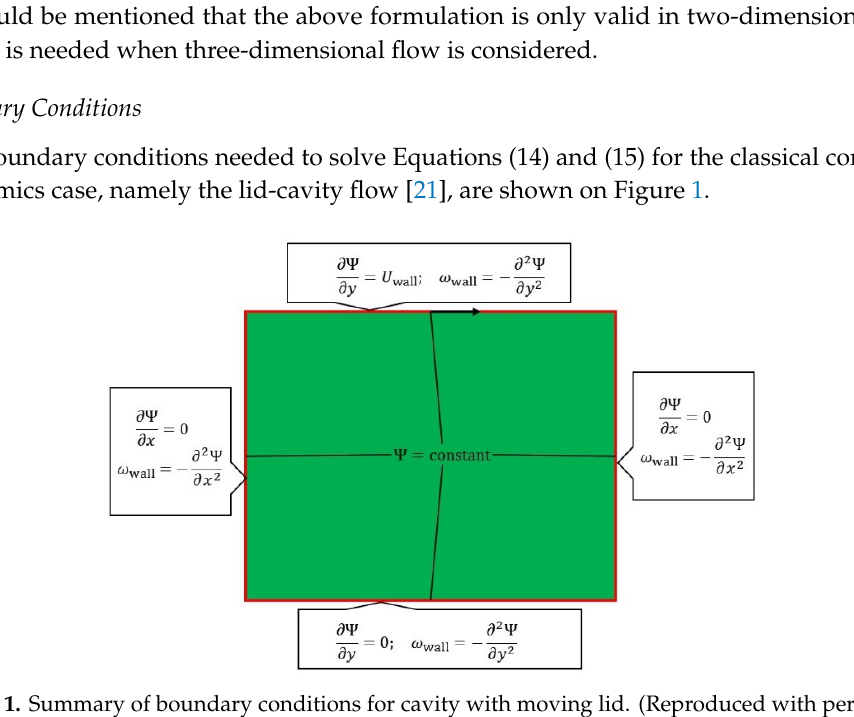
Figure 1. Summary of boundary conditions for cavity with moving lid. (Reproduced with permission from [22]).